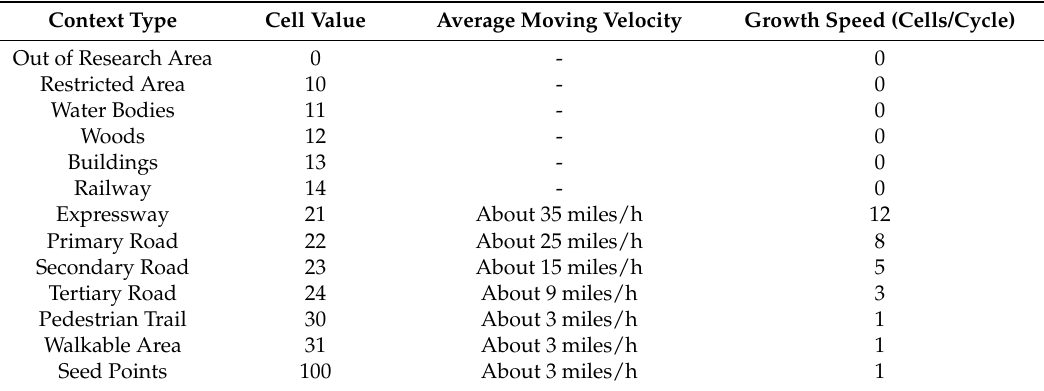
Table 2. Cell attributes of the hexagonal accessibility-weighted plane for private transport users.